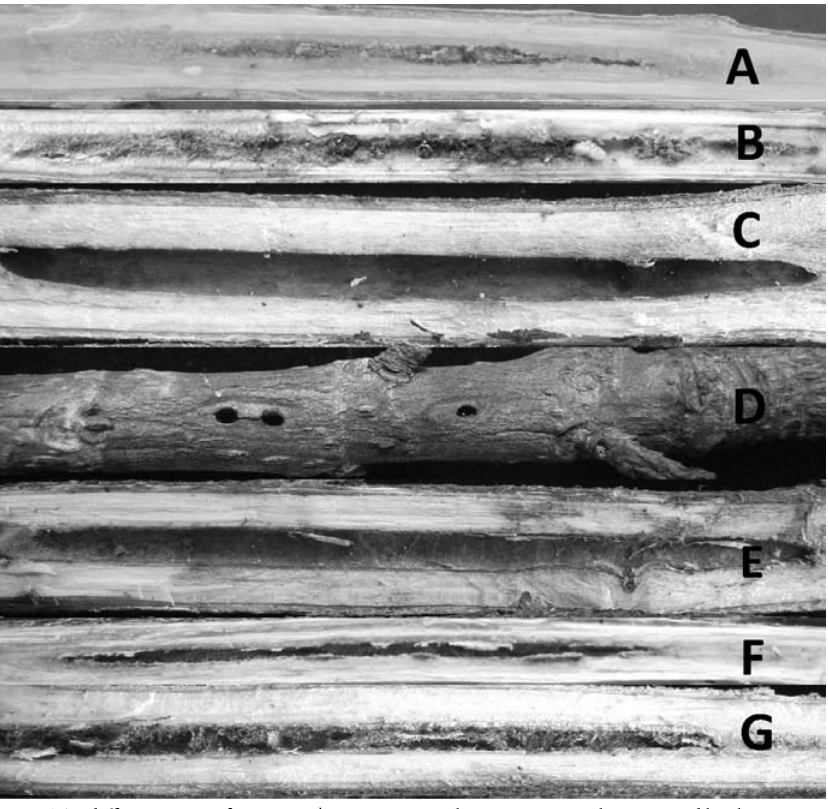
Fig. 1. The different types of cavities. A) Young cavity: these cavities are characterized by their young tissues. Only the central part is hollowed, the inner pith has not dried out yet. B) Young attacked cavity: the structure of the cavity is the same as for young cavities but insect larvae are feeding inside. C) Inhabited cavity: ants are observed inside. All pith tissue has been removed. D) Entry holes of an inhabited cavity. E) Formerly inhabited cavity: all the pith has been removed but no ant live inside. Often fungi or mould have grown on the inner surface. F) Mature cavity: the inner pith has dried out all along the internode. G) Old cavity: secondary growth is beginning to compress the